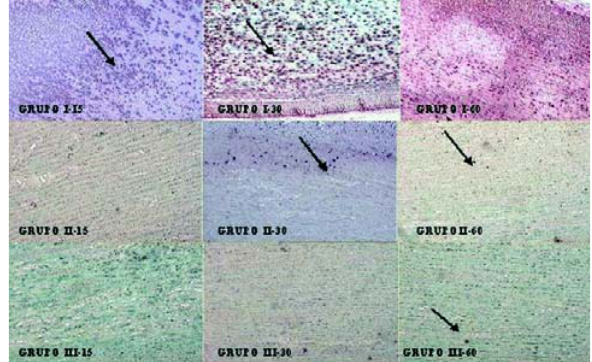
Fig. 3 - Fotomicrografias de condutos aórticos dos três grupos estudados, nos três períodos observados (alizarina 100X). No